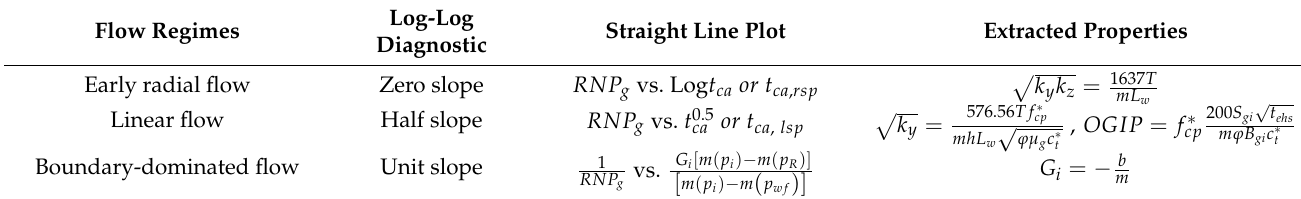
Table 1. Summary of flow analysis for a horizontal well in dry CSG reservoirs. Flow